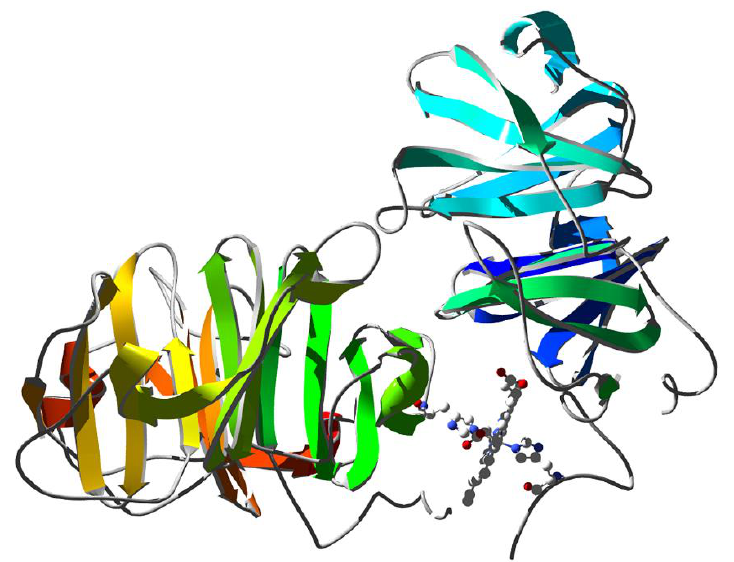
Figure 5. X-ray structure of rabbit serum hemopexin deglycosylated and complexed with heme (PDB ID 1QHU [137]). Ribbons are colored following secondary structure succession. Heme is shown together with the two histidine residues that coordinate the Fe